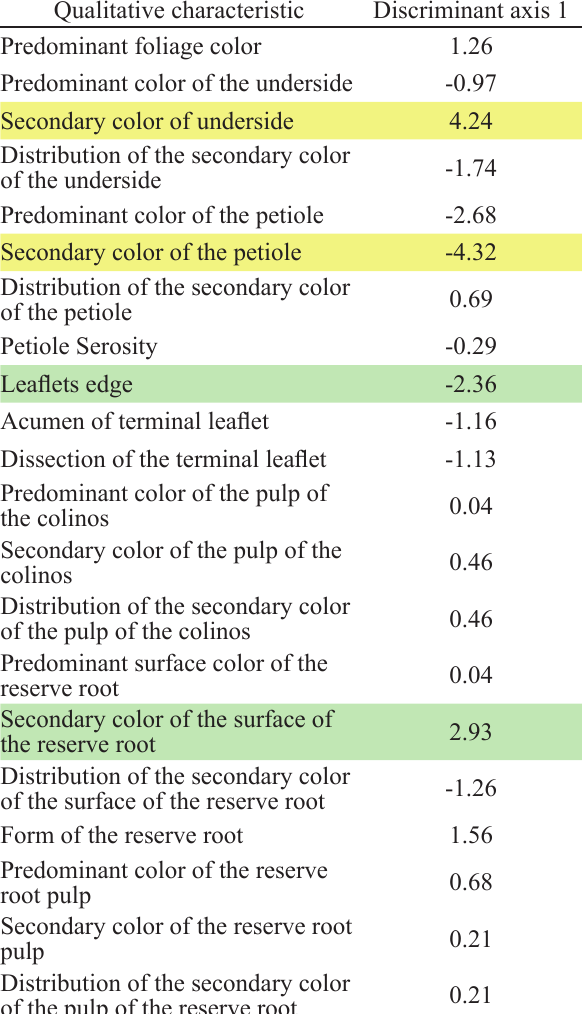
Table 1. Qualitative characteristics that discriminate the three phenotypic groups of 23 arracacha samples ( A. xanthorrhiza ) grown in the province of Marañón.